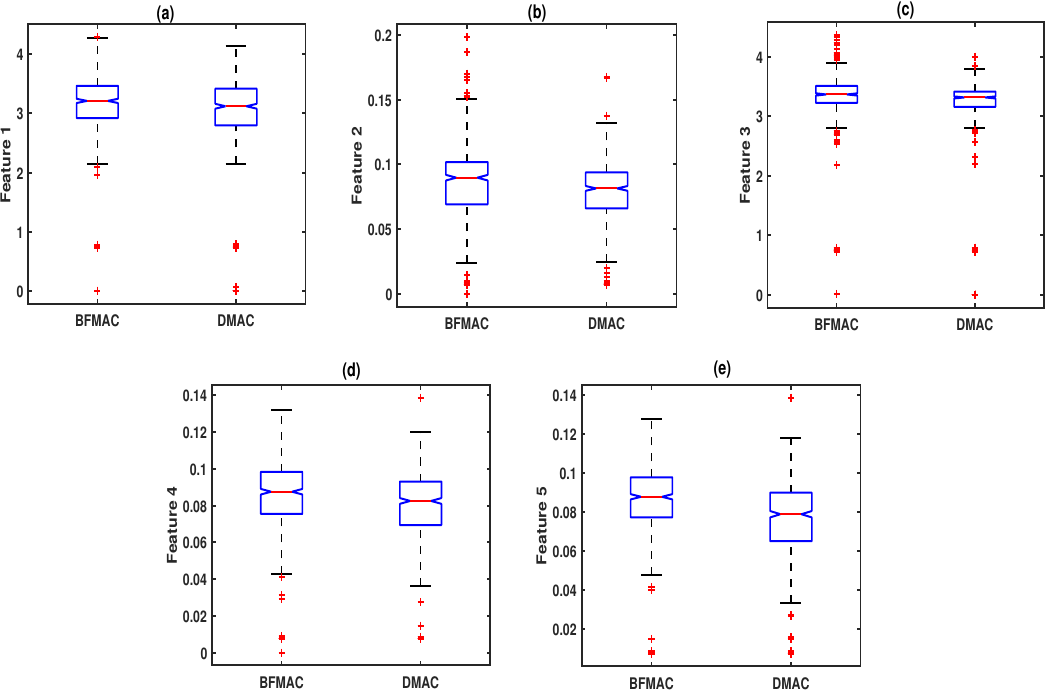
Figure 8. ( a ) Box-plots of the Fp1-channel EEG signal dispersion entropy features obtained for the BFMAC and DMAC classes. ( b ) Box-plots of the F7-channel EEG signal slope entropy features obtained for the BFMAC and DMAC classes. ( c ) Box-plots of the C4-channel EEG signal approximation entropy features obtained for the BFMAC and DMAC classes. ( d ) Box-plots of the O1-channel EEG signal sample entropy features obtained for the BFMAC and DMAC classes. ( e ) Box- plots of the O1-channel EEG signal permutation entropy features obtained for the BFMAC and DMAC